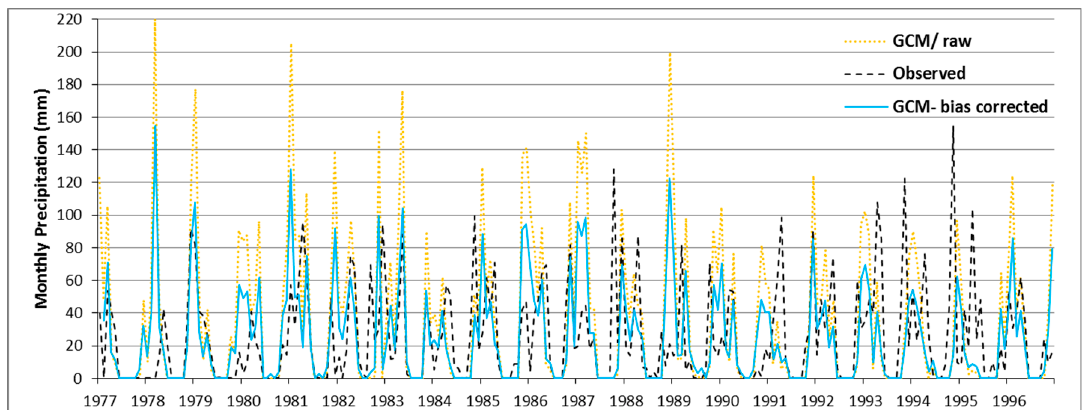
Table 5. Precipitation quantile bias (QB t ) as a function of the percentile obtained with the raw GCM, KDF and ECDF-QM variants.